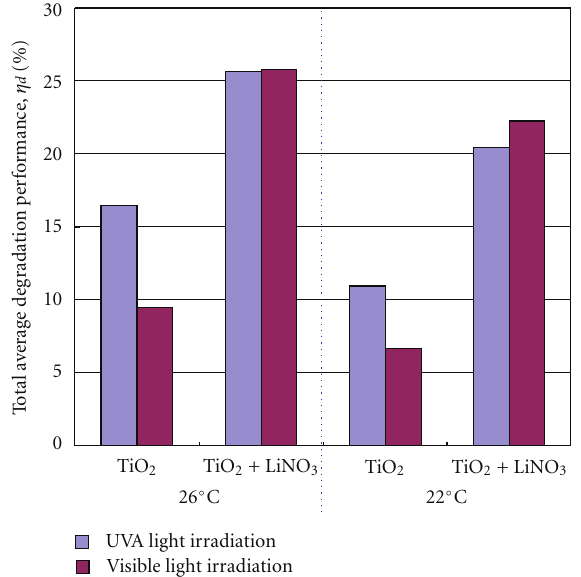
Figure 14: The total average degradation performance for gaseous